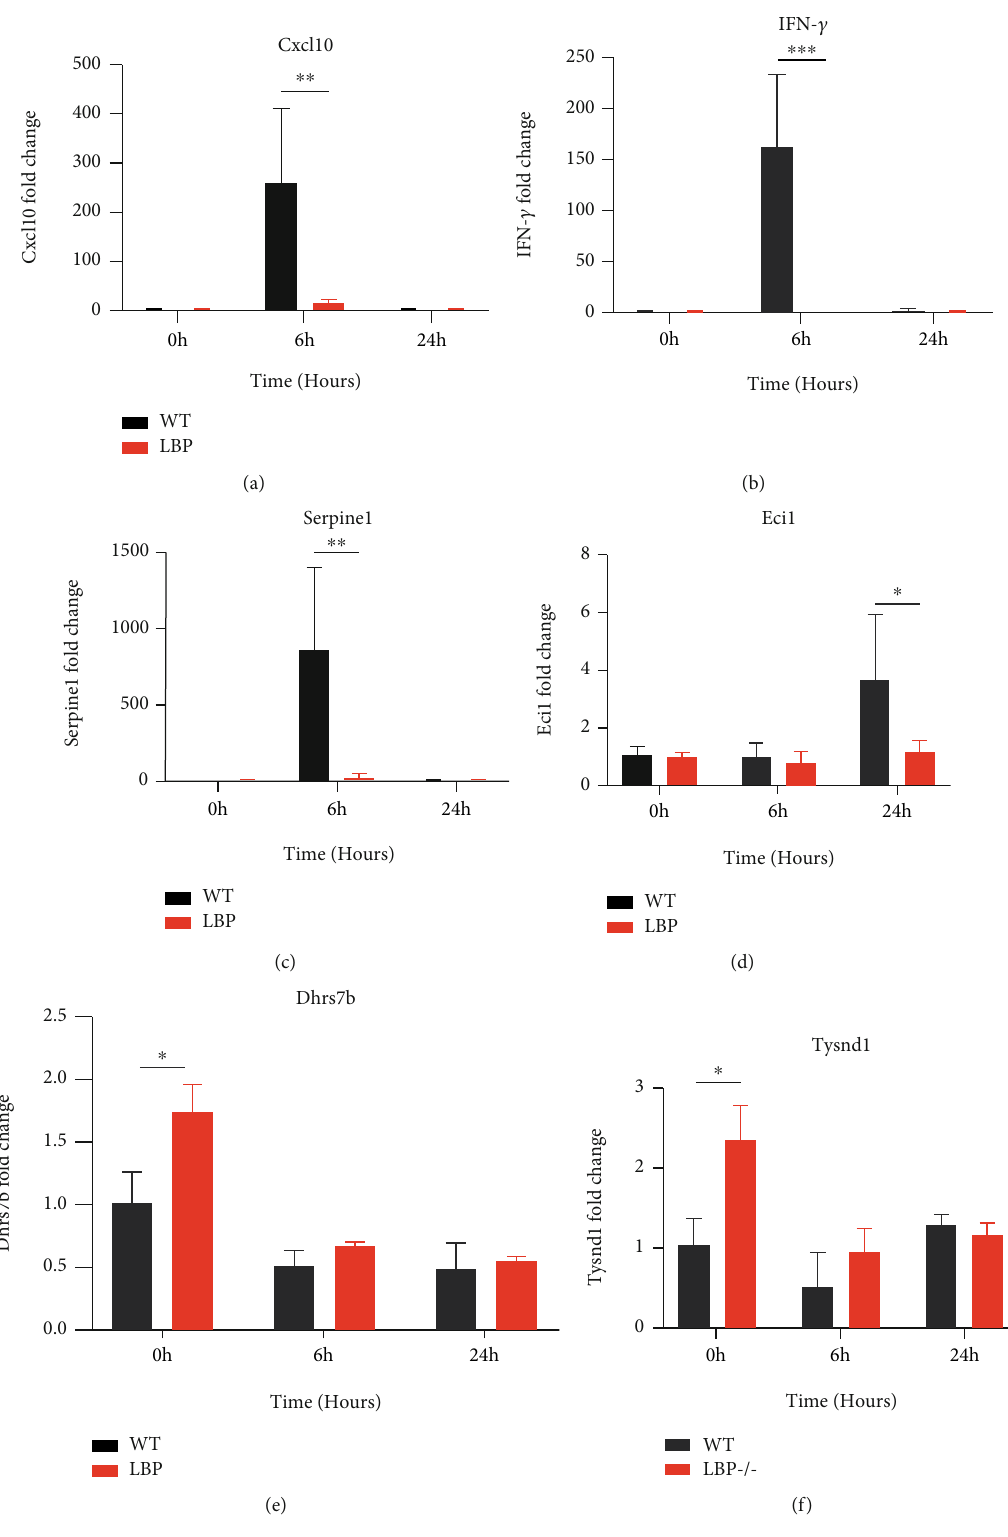
Figure 5: qPCR veri fi cation of DEGs in liver tissues between the normal and LBP-de fi cient rats in LPS-induced sepsis. Expression levels of interested genes from the transcriptome dataset were veri fi ed by qPCR analysis. The relative gene expression was determined using the 2 - ΔΔ Ct method with the normalization of GAPDH. (a – c) The inhibition of in fl ammation-related genes including Cxcl10 , Ifn- γ , and Serpine1 . (d – f) The upregulation of Eci1 , Dhrs7b , and Tysnd1 involved in the process of lipid metabolism. ∗ P < 0 : 05 , ∗∗ P < 0 : 01 , and ∗∗∗ P < 0 : 001 vs. normal